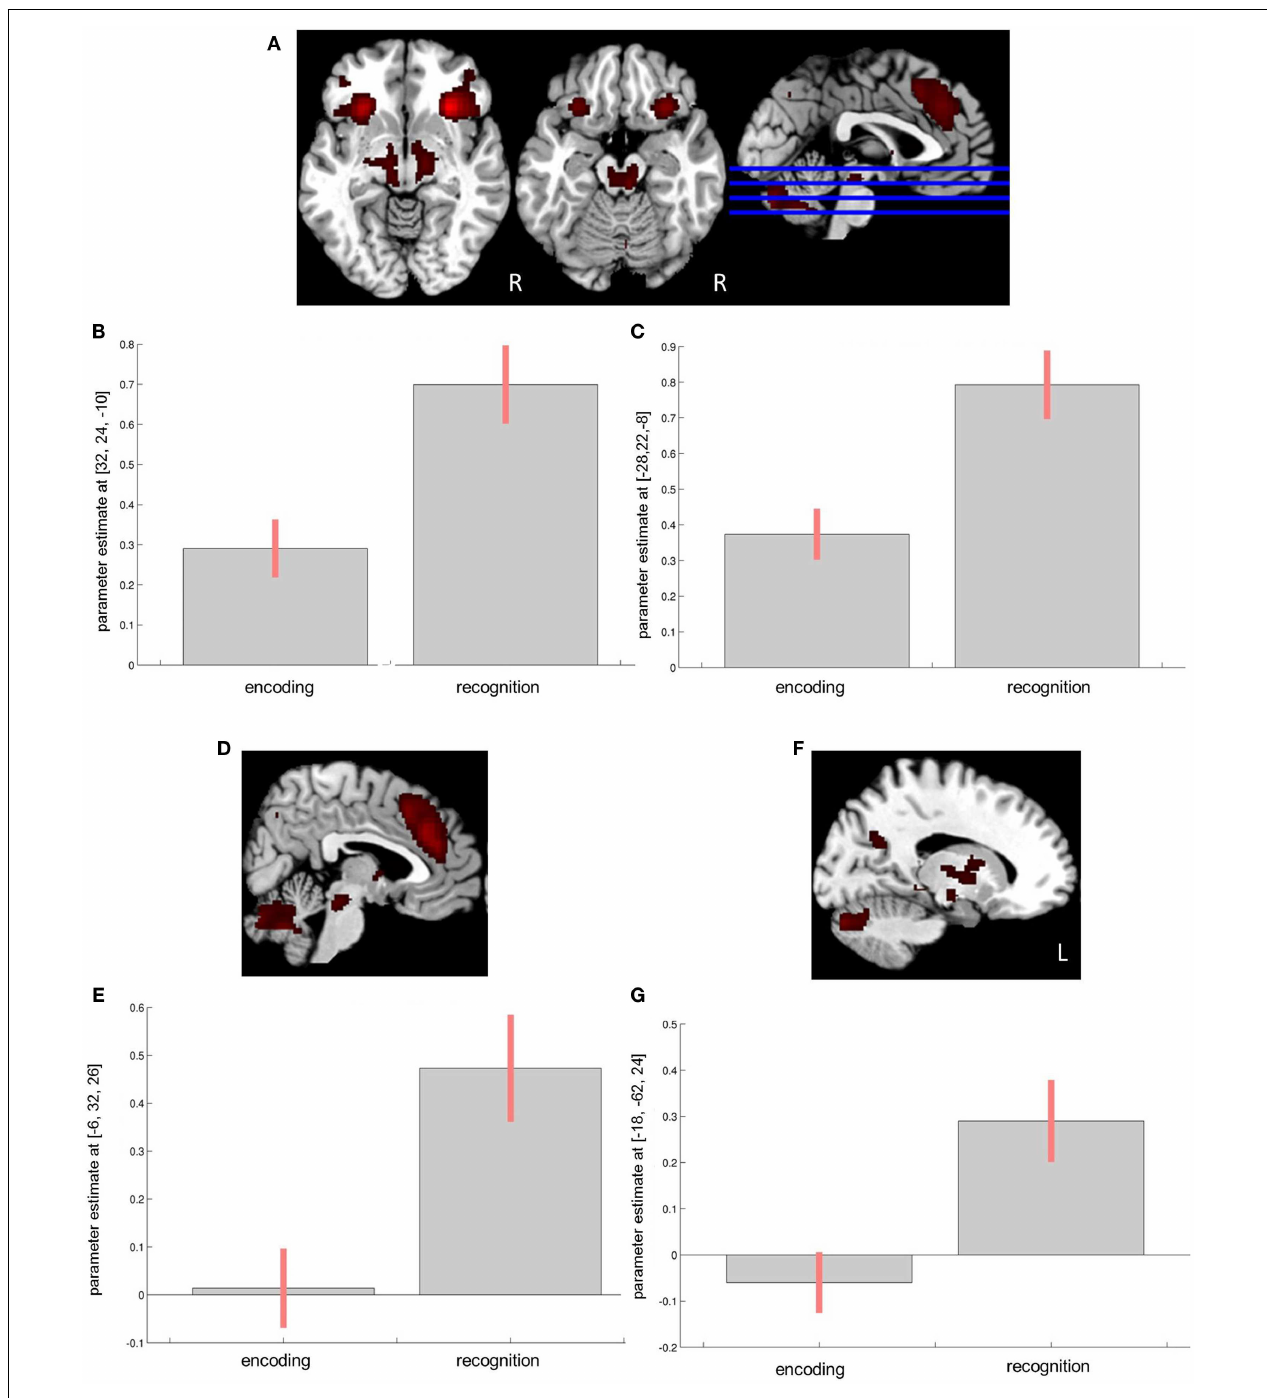
parameter estimates from the left insula. (D) Effects in the anterior cingulate cortex (ACC). (E) Corresponding parameter estimates from the ACC. (F) Effects in the left cuneus. (G) Corresponding parameter estimates from the left cuneus.